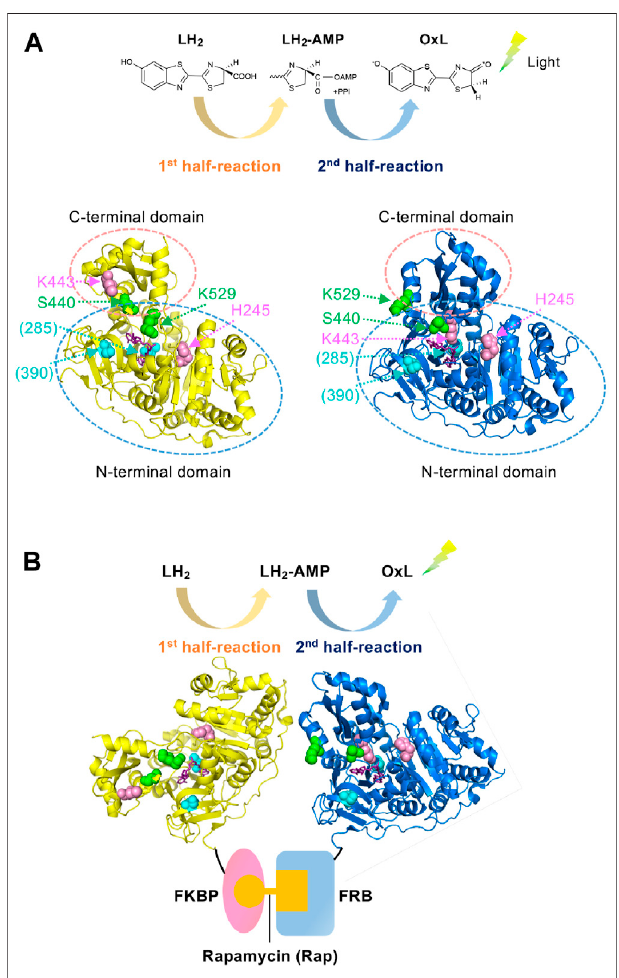
FIGURE1| WorkingprincipleofFlimPIA (A) Chemicalreactioncatalyzed by Fluc. Each of the two half-reactions is catalyzed by the different conformation. Ppy enzyme at the adenylation conformation (pdb 4G36) is shown in yellow, while that for the oxidative light-emitting reactions (pdb 4G37) is shown in blue. Magenta: the mutated residues in the Donor; green: those in the Acceptor; cyan: sites mutated for improved stability in LlL (in parentheses); purple; substrate analogue DLSA. The residue numbers are shown as those in Ppy throughout. (B) The scheme of FlimPIA in this paper. When the Donor is far from the Acceptor, LH 2 -AMP produced by the Donor does not reach the Acceptor. When the PPI between FKBP and FRB is induced by rapamycin, the Donor and Acceptor are in close proximity and the Acceptor catalyzes LH 2 -AMP produced by the Donor more ef fi ciently.